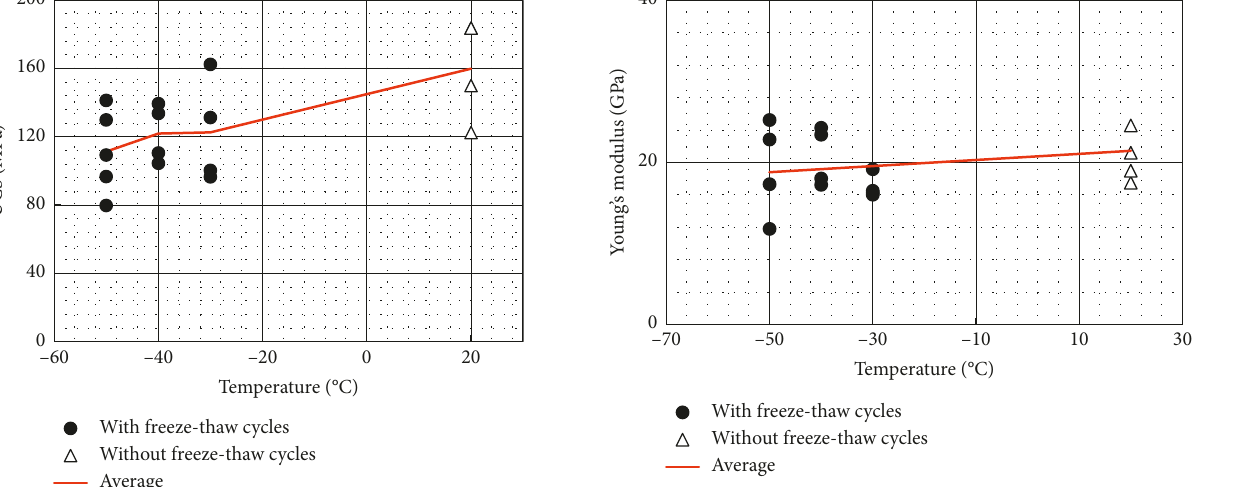
Figure 9: Uniaxial compressive strength (UCS) of tonalite with and without exposure to freeze-thaw cycling.